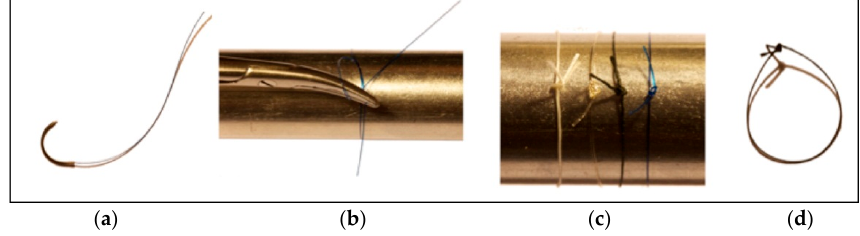
Figure 1. Sample preparation. ( a ) Suture material before tying; ( b ) Tying of suture material